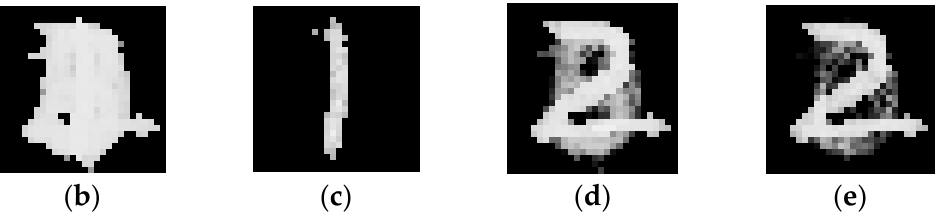
Figure 8. Graph of Weight Reconstruction. ( a ) result of Figure 7a; ( b ) result of Figure 7b; ( c ) result of Figure 7c; ( d ) result of Figure 7d; ( e ) result of Figure 7e.